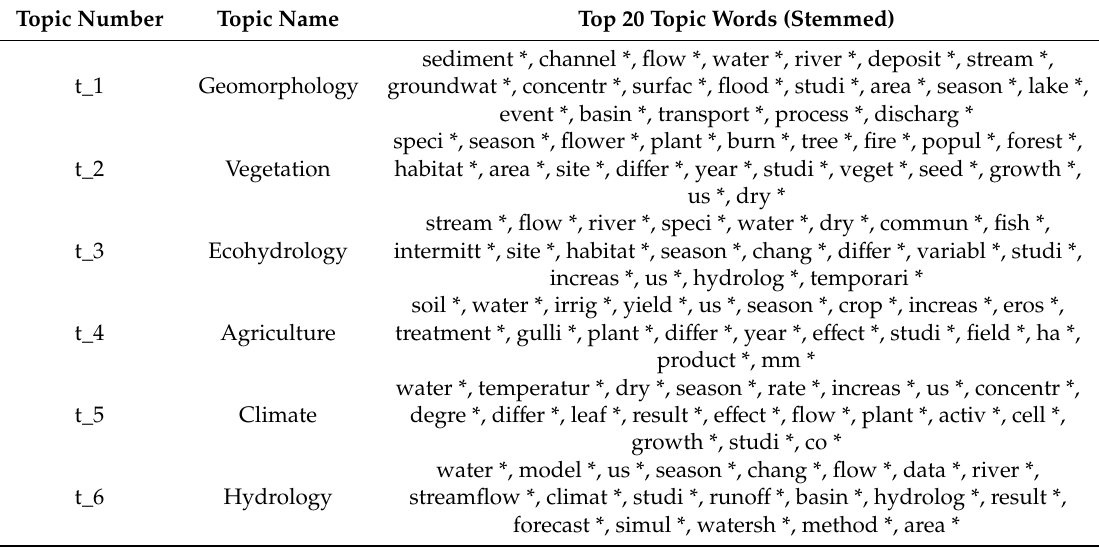
Table A1. Complete Corpus